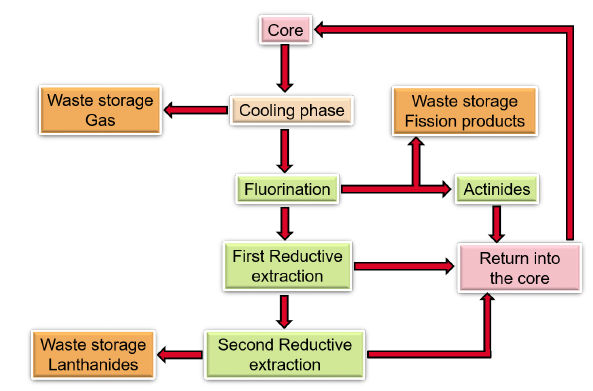
Figure 1. Scheme of the chemical plant